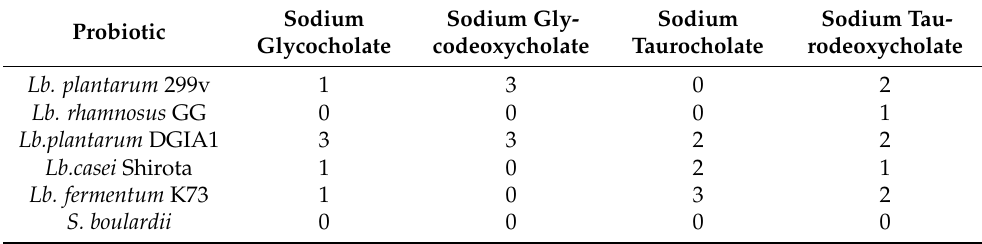
Table 2. BSH activity of probiotic strains grown on bile salt—MRS medium as manifested by the formation of a precipitation zone around the colony. The diameters of the precipitation zones are expressed in